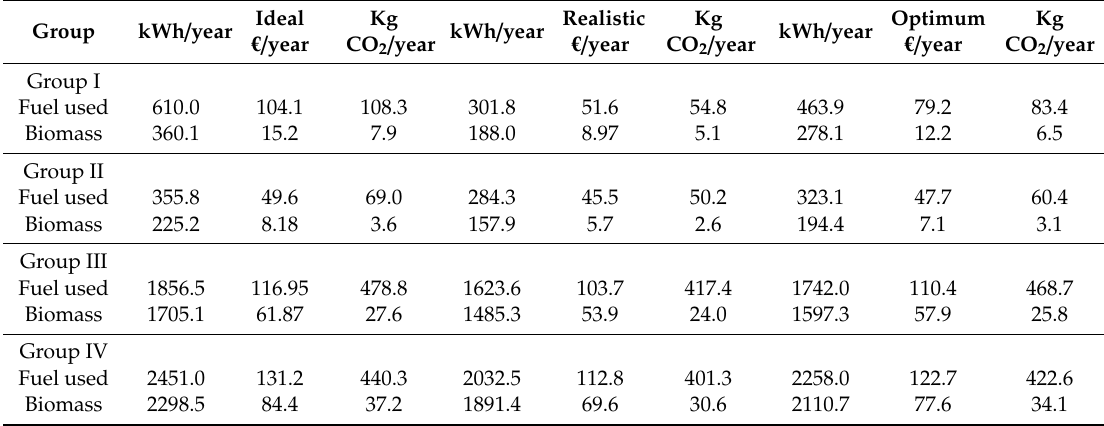
Table A11. Comparative results in municipalities